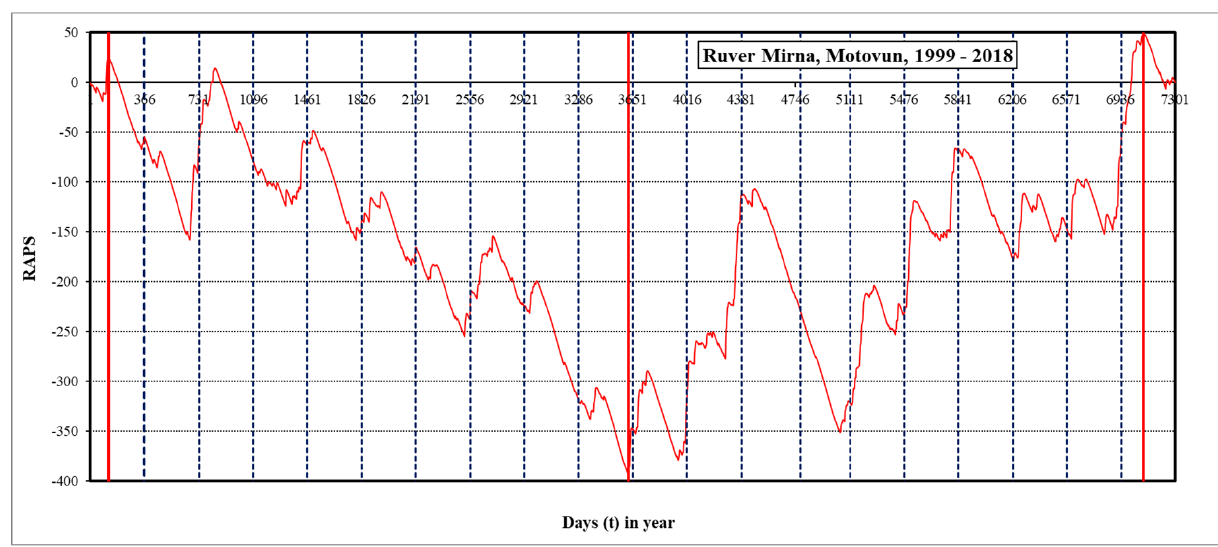
Figure 7. RAPS diagram for the river Mirna .